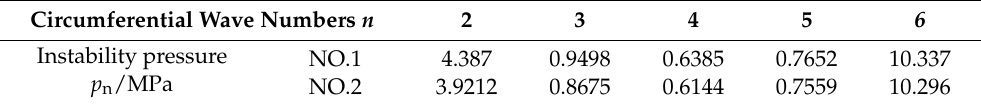
Table 4. Analytical results.